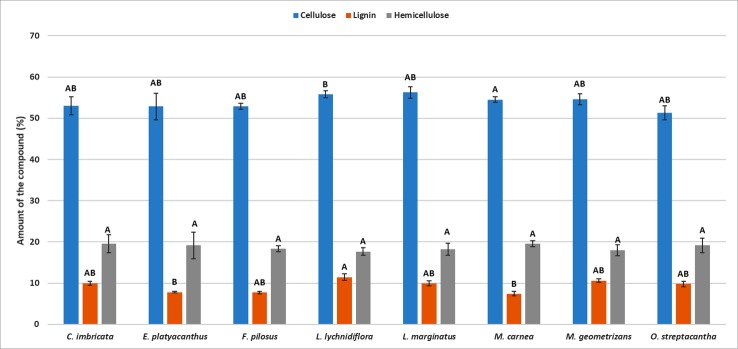
Mean of the percentages for each lignocellulosic compound in eight Cactaceae species. Different letters indicate significant differences between means based on pairwise multiple comparison Dunn’s test (p ≤ 0.05). Bars represent standard deviation.